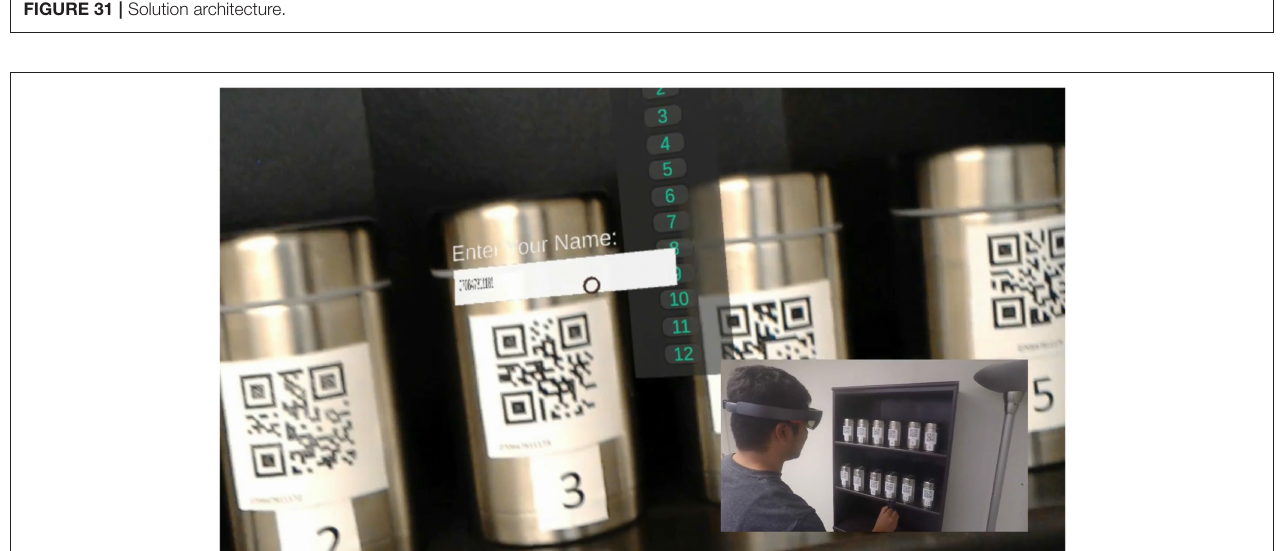
FIGURE 32 | Bar-code scanning